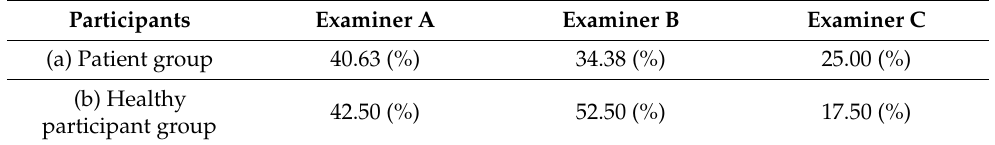
Table 2. Comparison of the agreement between the subjective FER reported by the three examiners and the FER based on MTCNN face detection in the patient and healthy participant groups.